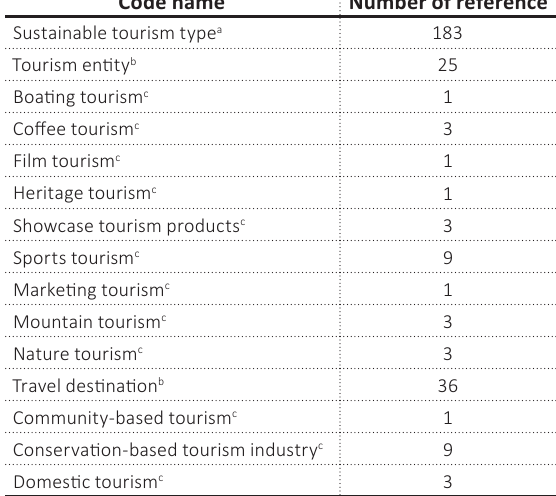
Table 3. The coding process of tourism for sustainable tourism type